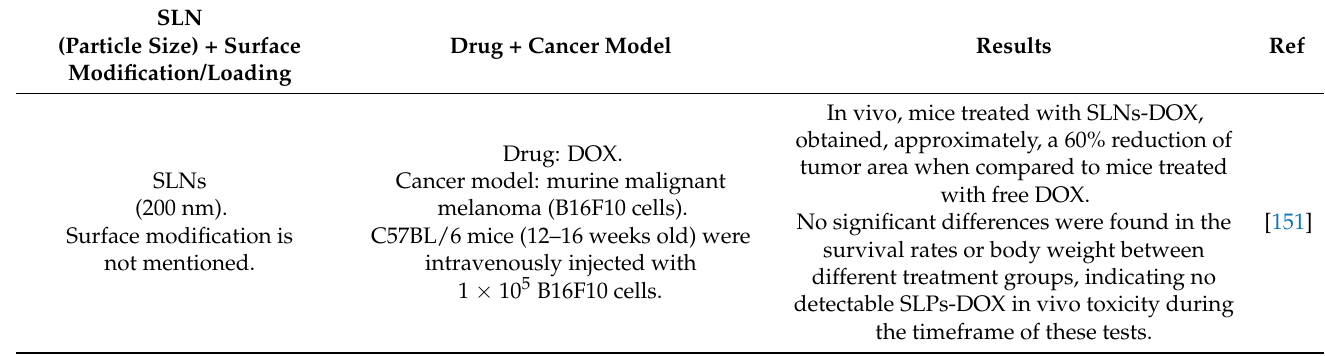
Table 4. Solid lipid nanoparticles (SLNs) as drug delivery systems for cancer